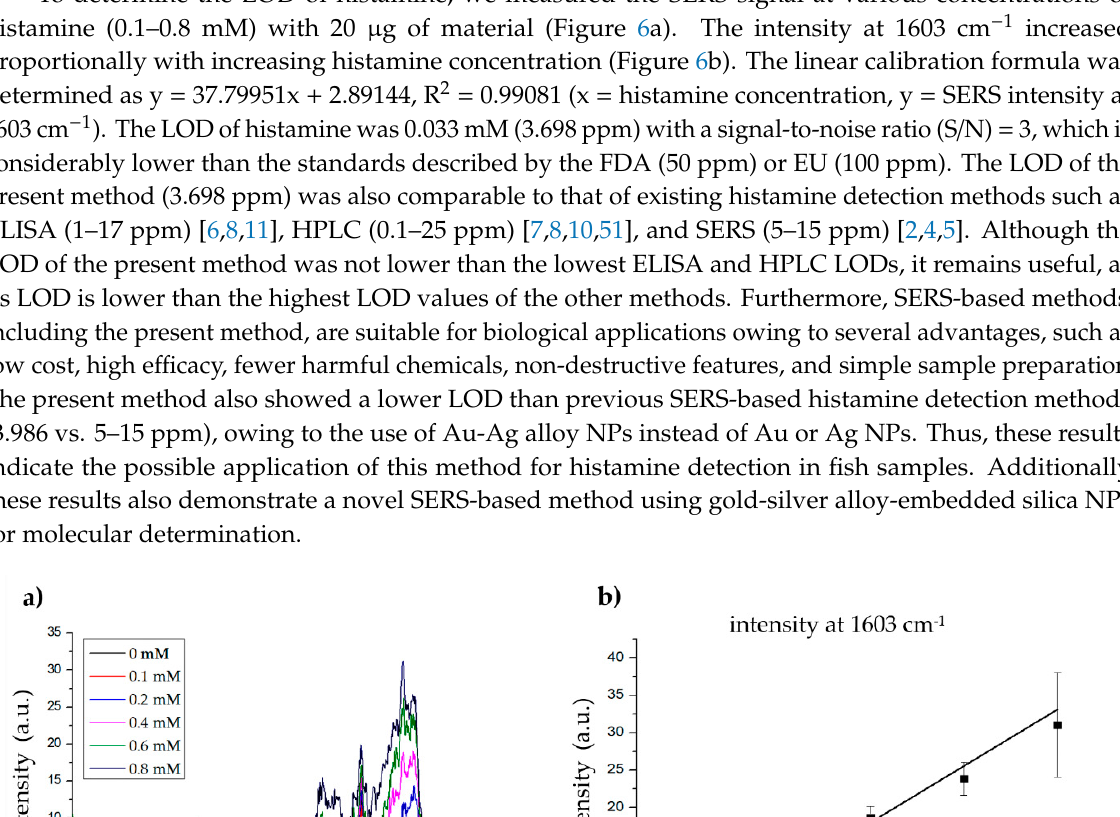
Figure 5. Effect of material concentration on histamine detection. ( a ) The Raman signal of the same concentration of histamine incubated with 1, 0.5, 0.25, 0.125, and 0.0625 mg/mL of SiO 2 @Au@Ag nanoparticles (NPs). ( b ) The Raman intensity of histamine for different concentrations of SiO 2 @Au@Ag NPs (at 1603 cm -1 ).